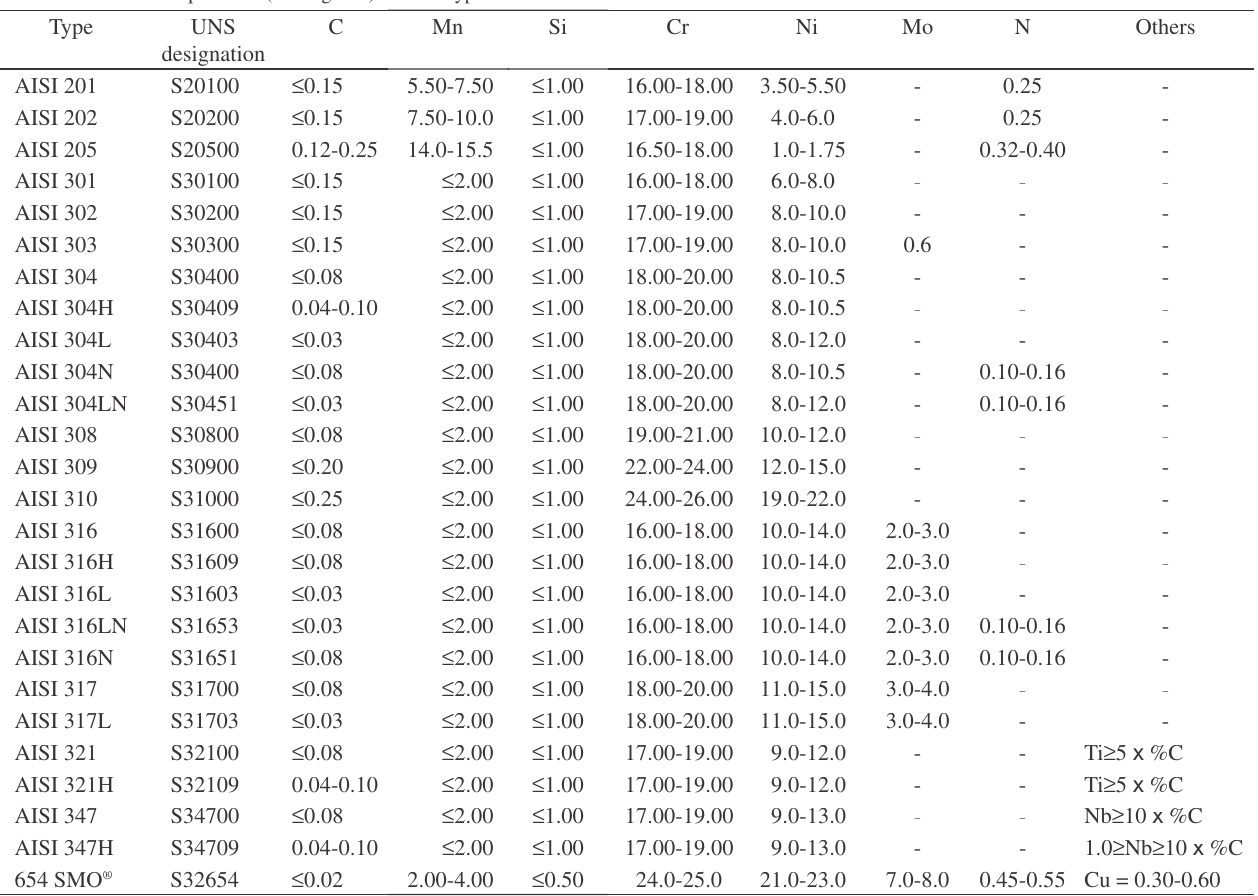
Table 1. Chemical compositions (in weight %) of some typical ASSs 1 .